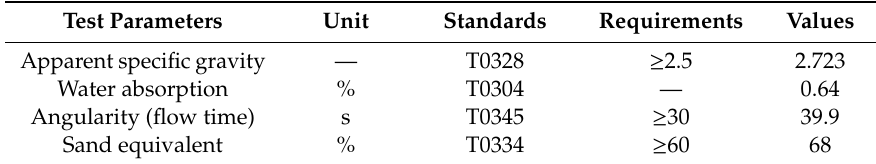
Table 3. Technical properties of basalt fine aggregates.